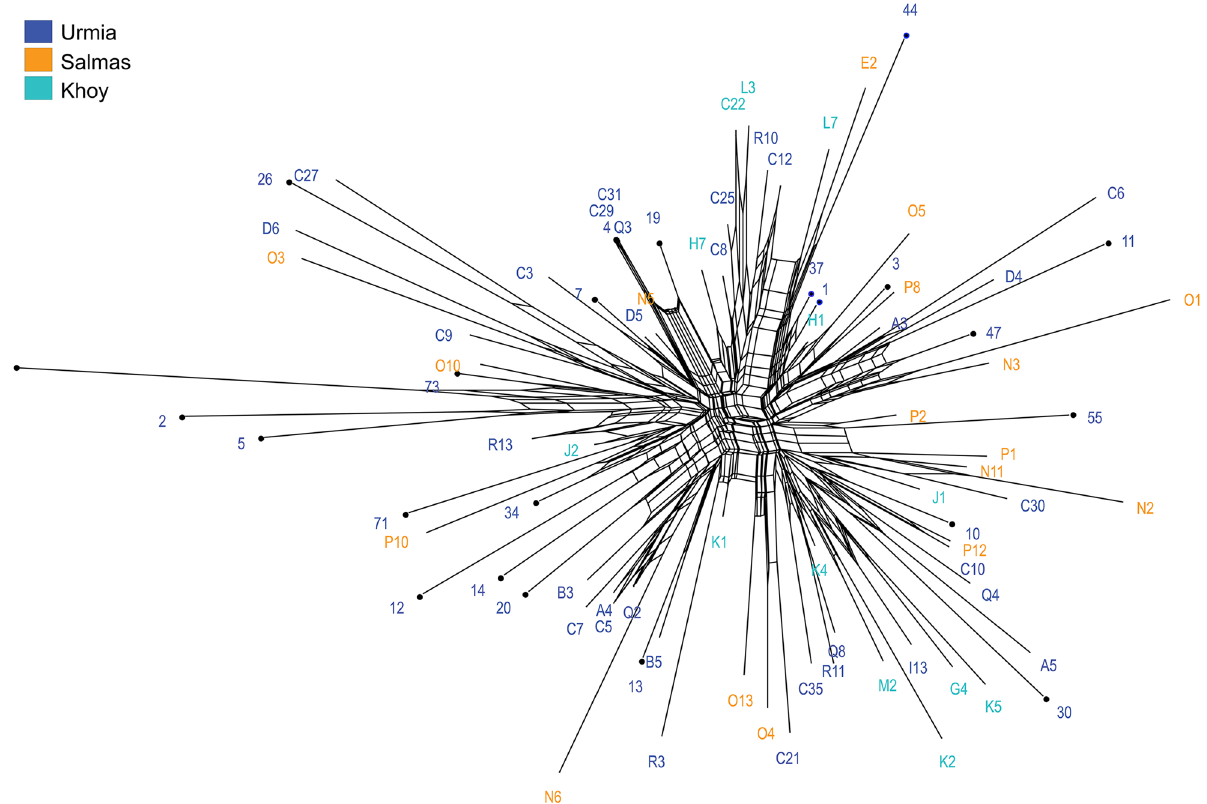
Figure 4. Neighbor-Net graph for 84 ISSR multilocus genotypes (MLGs) of Sclerotinia sclerotiorum from sunflower and cabbage fields in three regions (Urmia, Salmas and Khoy) in West Azarbaijan province of Iran. The isolates from cabbage fields are indicated by black circles at the nodes. Reticulations reveal possible recombination events.